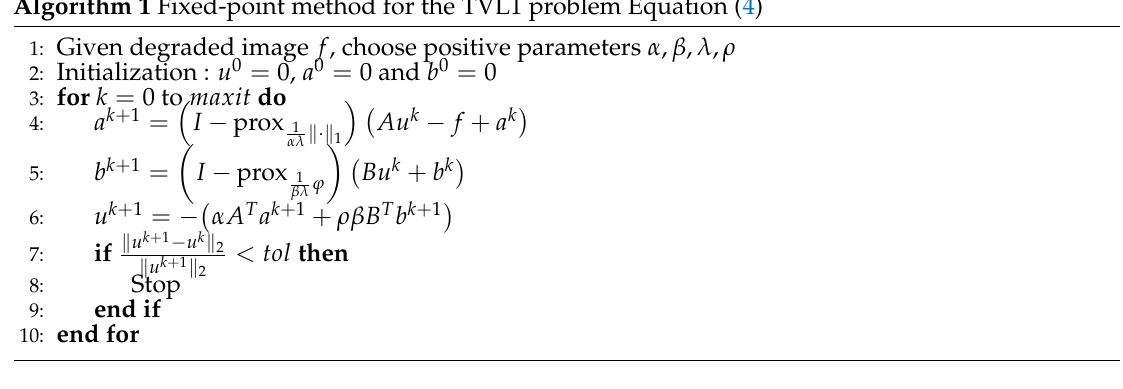
Algorithm 2 Fixed-point-like method for the TVL1 problem Equation